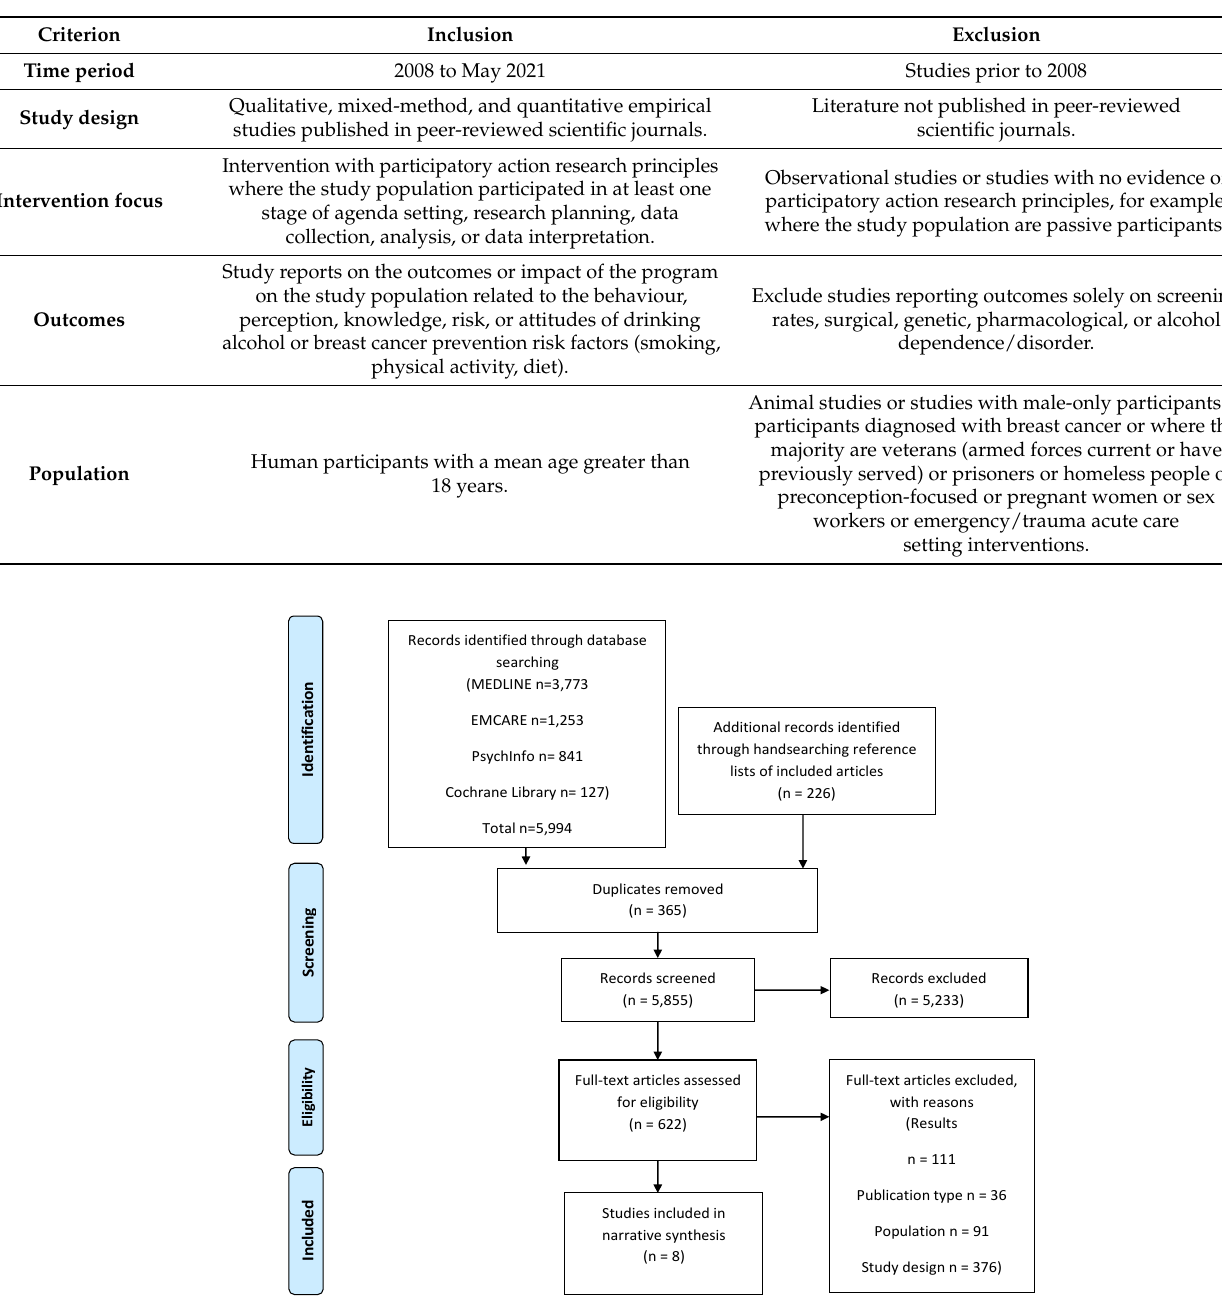
Figure 2. Search result PRISMA diagram.